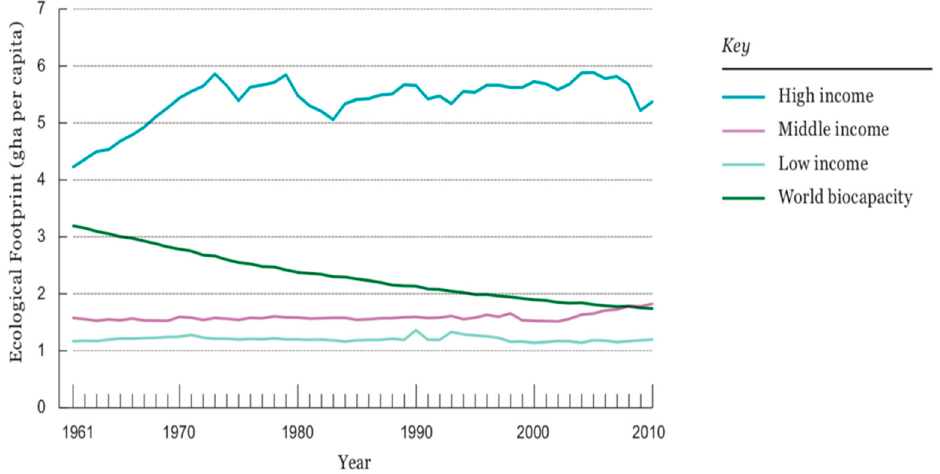
Figure 4. Inequality in the ecological footprint, 1961–2010. Shows ecological footprint per capita (gha / cap) in high-, middle- and low-income countries. The green line represents world average biocapacity per capita (Global footprint Network 2014, World Bank 2013. Source: WWF—World Wide Fund for Nature (2014) Living Planet Report. © 2014 WWF—All rights reserved.